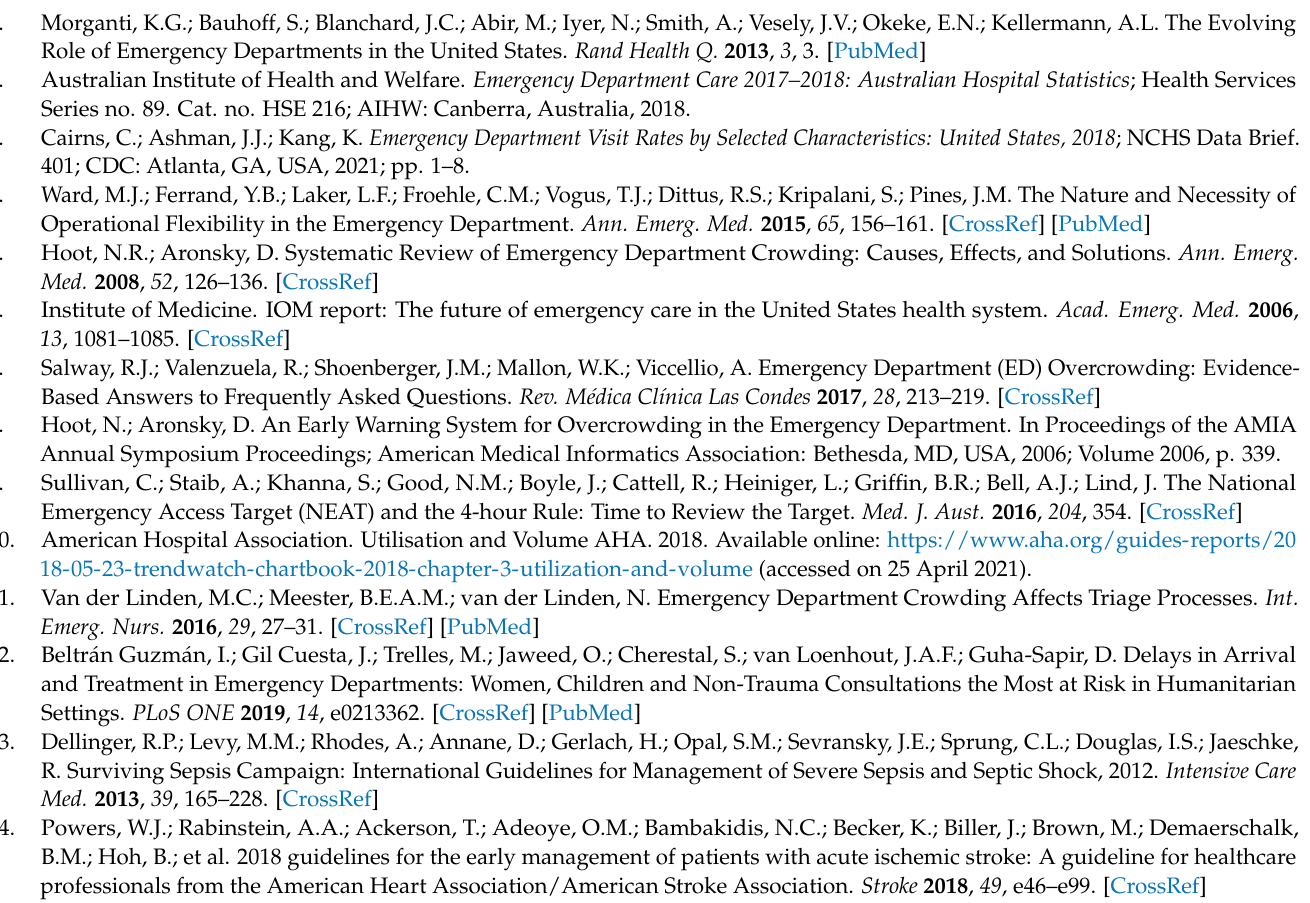
Study Selection; Table S1: Characteristics of included studies; Table S2: CASP checklist for cohort studies; Table S3: JBI checklist for cross-sectional studies; Table S4: Delay of analgesia as recorded by median